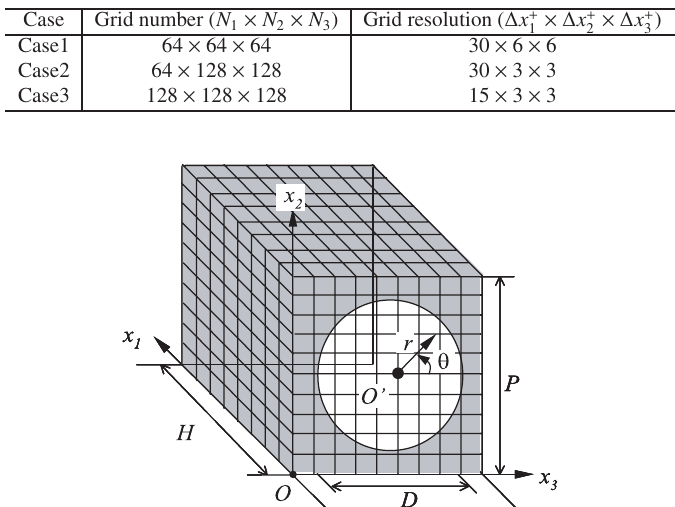
Fig. 1 Computational domain for pipe.